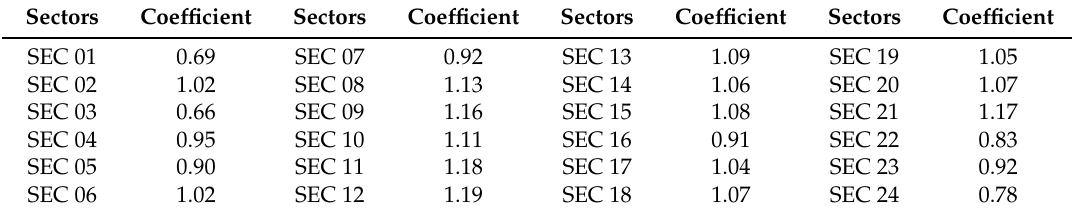
Table 7. The average influence coefficients in all sectors from 1997 to